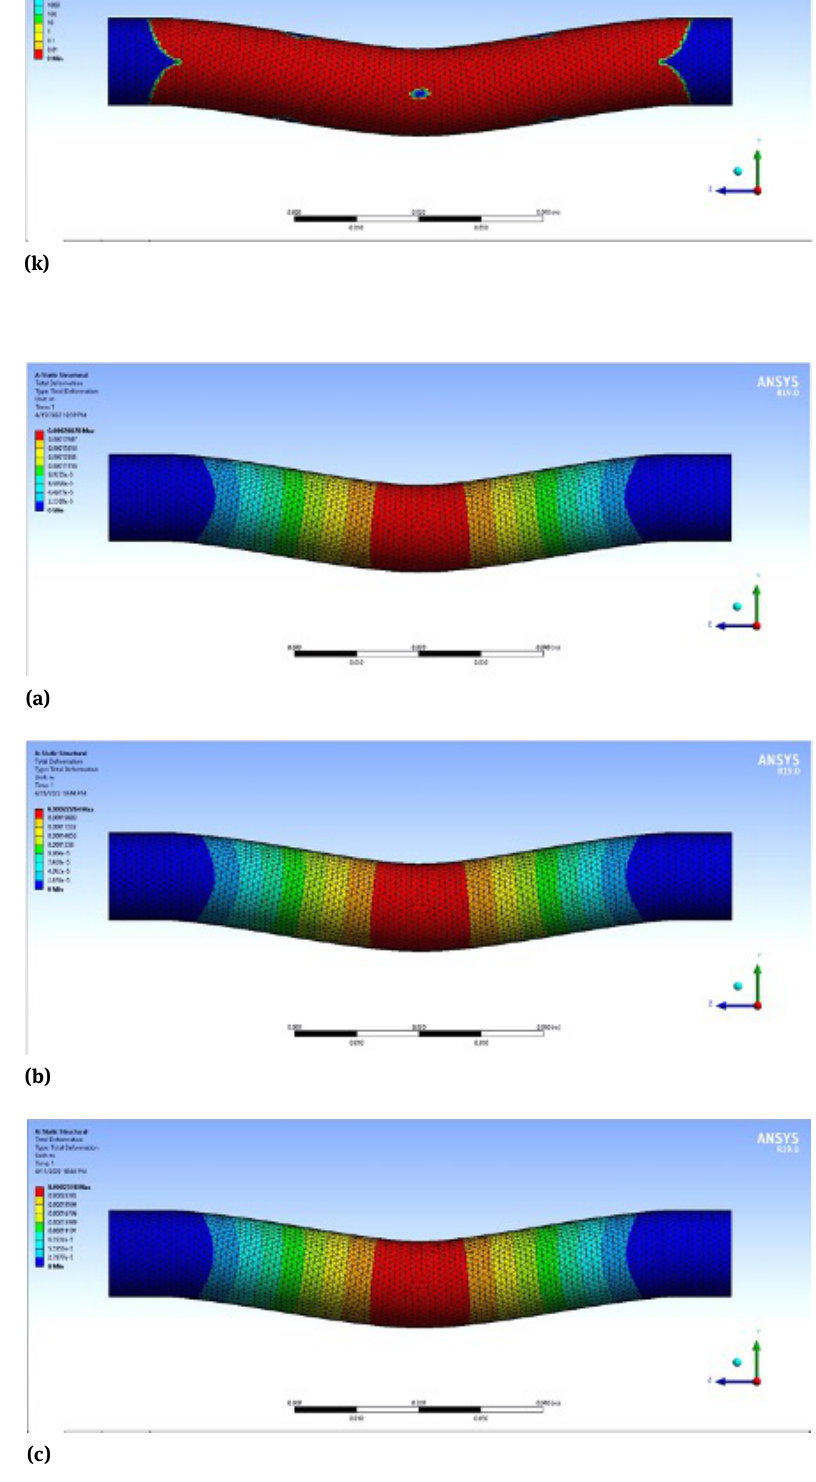
Figure 8: Deformation contour. (a) 0 0 0, (b) 0 0 45, (c) 0 0 90, (d) 0 45 0, (e) 0 45 90, (f) 0 90 0, (g) 45 0 0, (h) 45 45 45, (i) 90 0 0, (j) 90 45